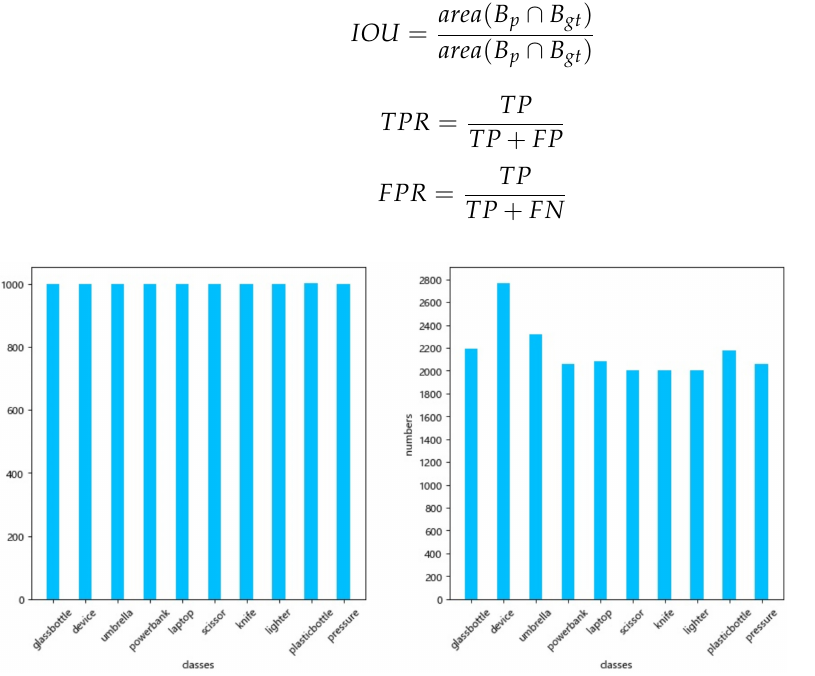
Figure 9. ( Left ) Number of target instances in EDS_5k. ( Right ) Number of target instances in EDS_10k.